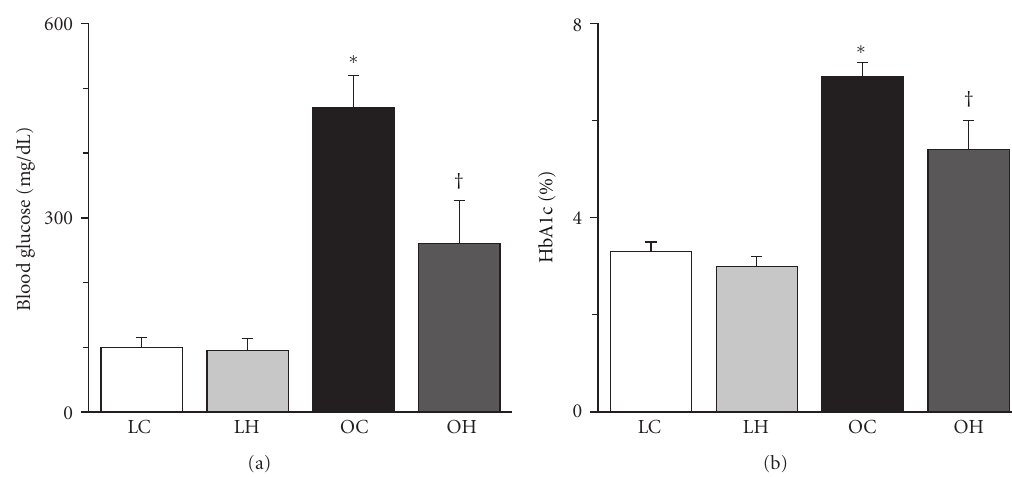
Figure 1: Blood glucose (a) and HbA1c (b) at the end of treatment. The values of blood glucose and HbA1c are presented as the mean ± SEM. ∗ and † are significantly di ff erent from the LC and OC groups, respectively, at P < 0 . 05. The following abbreviations are used for Figures 1–8. LC: LETO control (non-diabetic animals); LH: LETO exposed to hyperbaric oxygen; OC: OLETF control (diabetic animals); OH: OLETF exposed to hyperbaric oxygen. N = 4 in the LC group, n = 5 in the LH group, n = 5 in the OC group, and n = 6 in the OH group.